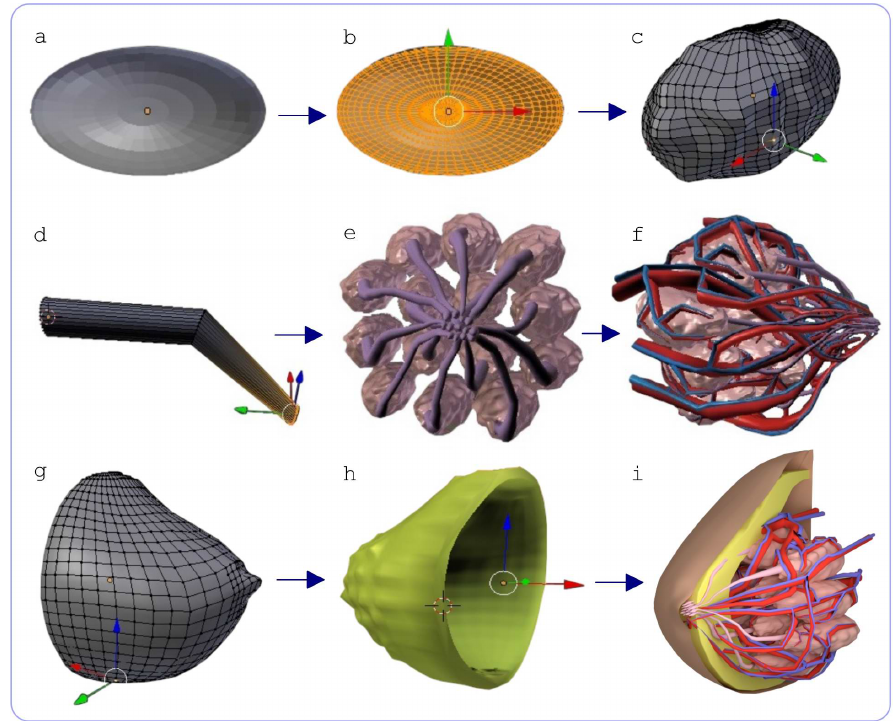
Figure 7. Procedure to construct a 3D breast model of different components in Blender: steps for constructing a single breast lobe model ( a – c ), system of the lactiferous sinus and breast lobes ( d – e ), the blood flow includes arteries (red) and veins (blue) ( f ), the skin ( g ), the subcutaneous fat pad ( h ), and the section of the final 3D model of the breast with textures ( i ).